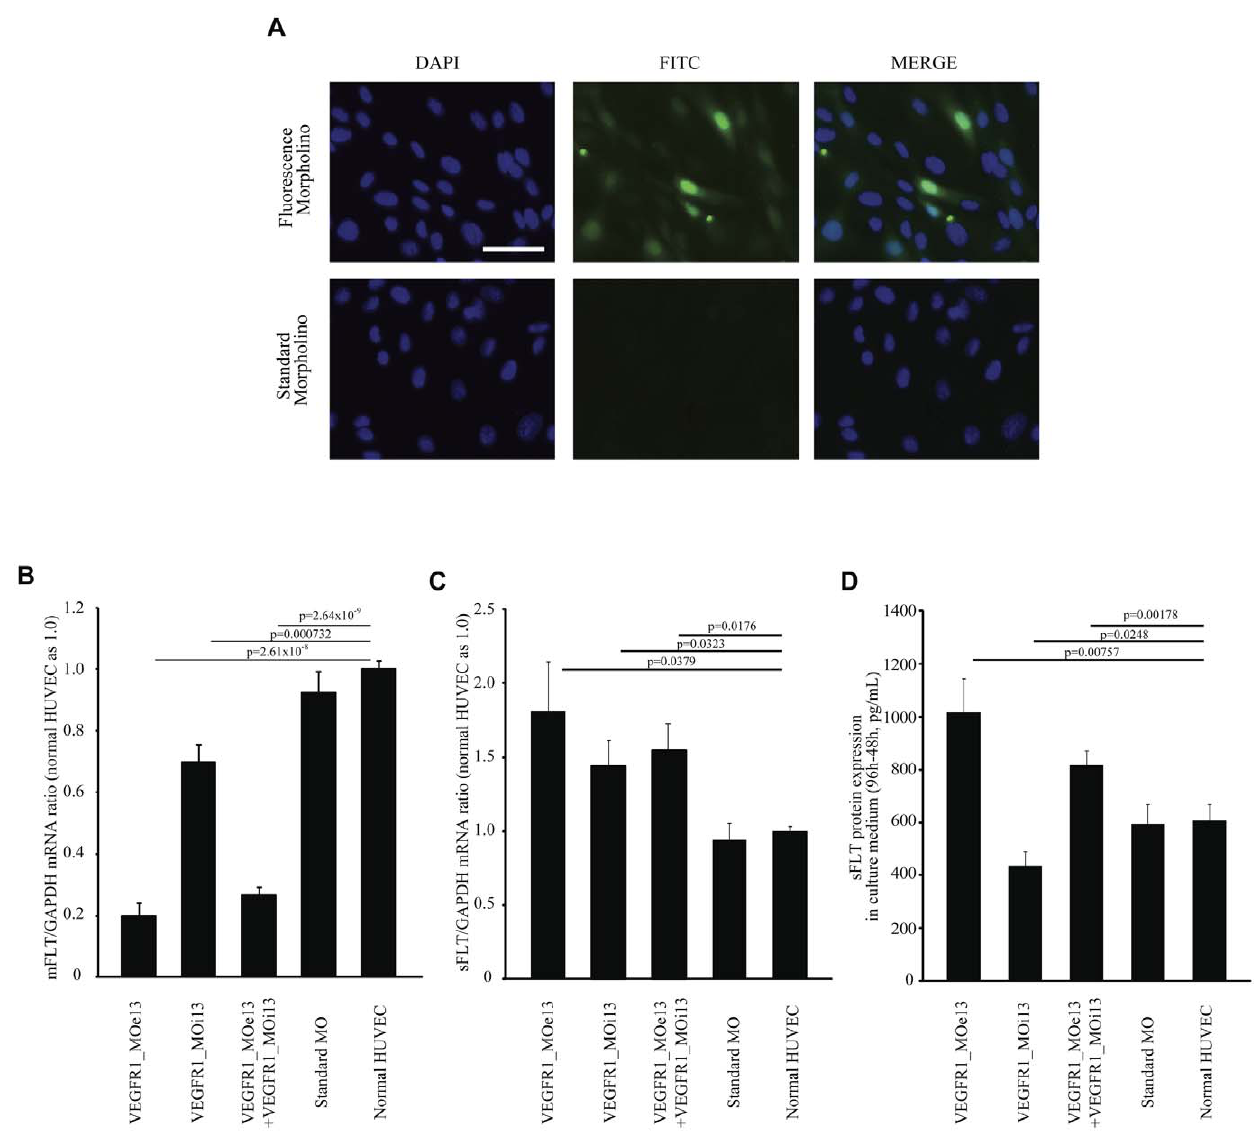
Figure 1. VEGFR1_MOe13 localizes to the nucleus and increases sFLT-1 expression in human endothelial vein cells (HUVEC). (a) Fluorescently tagged VEGFR1_MOe13 (F-MO) or standard morpholino (std-MO) were electroporated into HUVECs. After 48 hours fluorescence was assessed using light microscopy. Colocalization with DAPI staining represents nuclear localization of morpholino constructs. HUVECs were electroporated with VEGFR1_MOe13, VEGFR1_MOi13, a combination of VEGFR1_MOe13 and VEGFR1_MOi13, Standard_MO. All morpholino sequences were designed to target the human VEGFR1 transcript. (b) mbFLT-1 mRNA (n=6) or (c) sFLT-1 mRNA expression (n=6) were assessed using real time PCR. Values were normalized to GAPDH mRNA and normal HUVEC was used as 1.0. (d) sFLT protein expression in culture medium was determined by ELISA (n=3). Data shows sFLT protein at 96 h – 48 h. Error bar is S.E.M. Each p-value was calculated by two-tail student’s t-test against normal